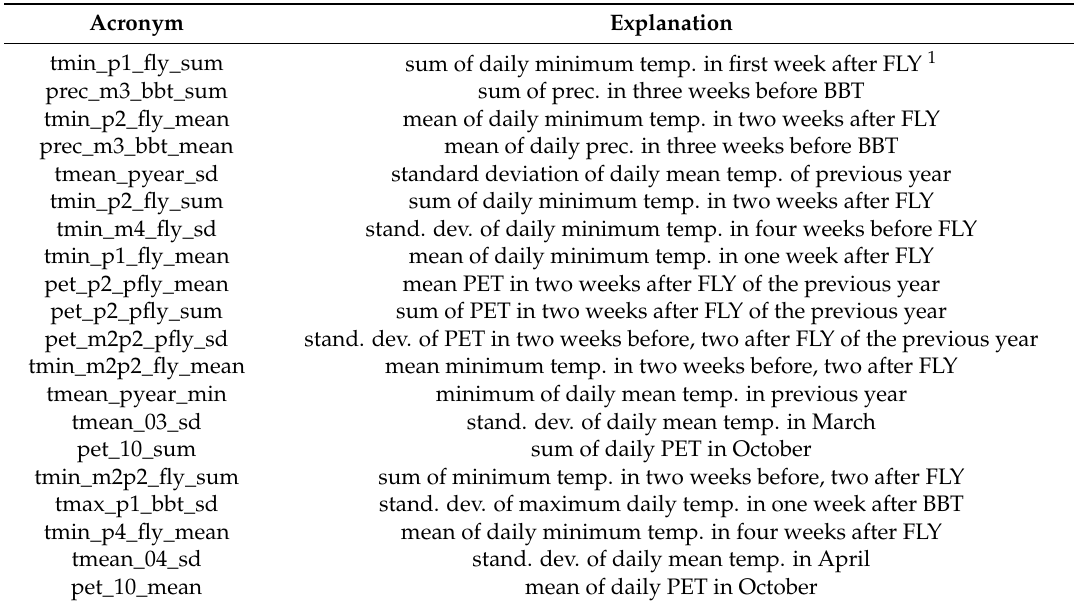
Table 1. Description of the top 20 explanatory climate